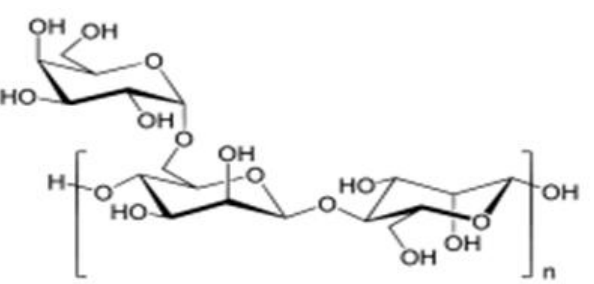
Figure 10. Structure of Guar